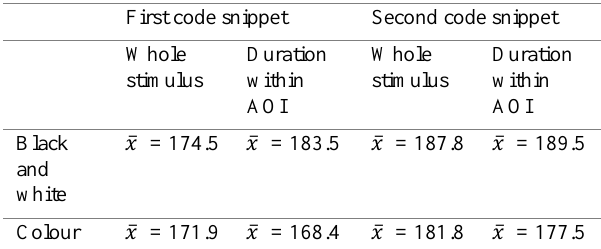
Figure 3: The two string formatting lines as used in the second code